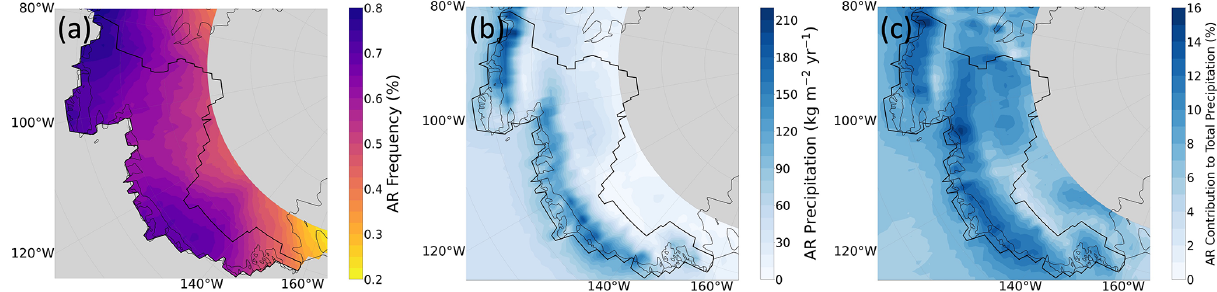
Figure 2. (a) Temporal frequencies of AR landfall (number of AR times divided by the total time, as a percentage), (b) precipitation attributed to ARs, and (c) AR precipitation as the percentage of the total annual precipitation in West Antarctica (MERRA-2, 1980 to 2020). The Amundsen Sea Embayment and Marie Byrd Land (region of interest) are outlined in black in all three figures. Gray shading over the interior of the ice sheet marks the 80 ◦ S boundary of the Wille et al. (2021) AR detection algorithm.